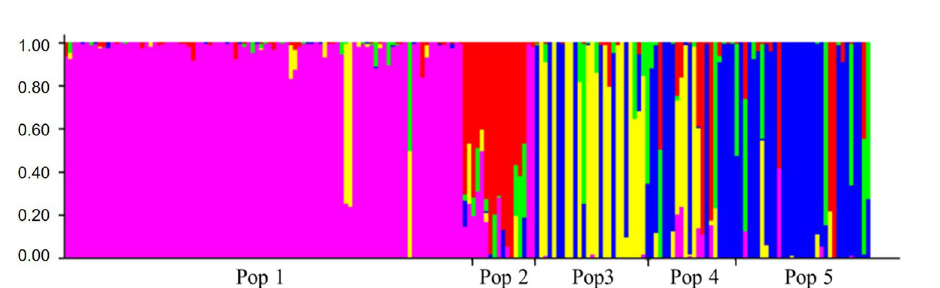
Figure 7. Population structure of the 190-clone sugarcane mini-core using the Structure bar plot (K = 5). Pop 1 = Saccharum hybrids, Pop 2 = S. officinarum , Pop 3 = S. spontaneum , Pop 4 = Saccharum sp., Pop 5 =